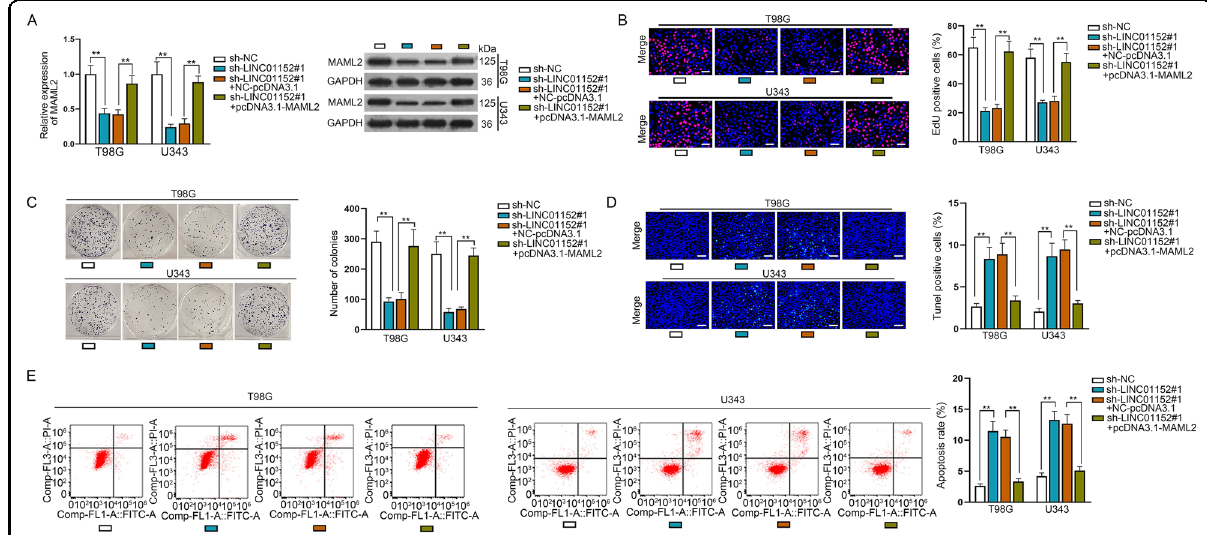
Fig. 7 LINC01152/MAML2 axis could facilitate the progression of GBM. A qRT-PCR and western blot searched the mRNA and protein levels of MAML2 in LINC01152-silenced T98G and U343 cells with or without MAML2 overexpression. B , C EdU (scale bar = 100 μ m) assay and colony formation assay assessed the proliferation of T98G and U343 cells in different groups. D , E TUNEL (scale bar = 120 μ m) assay and fl ow cytometry analysis investigated the apoptosis of indicated T98G and U343 cells. ** P <